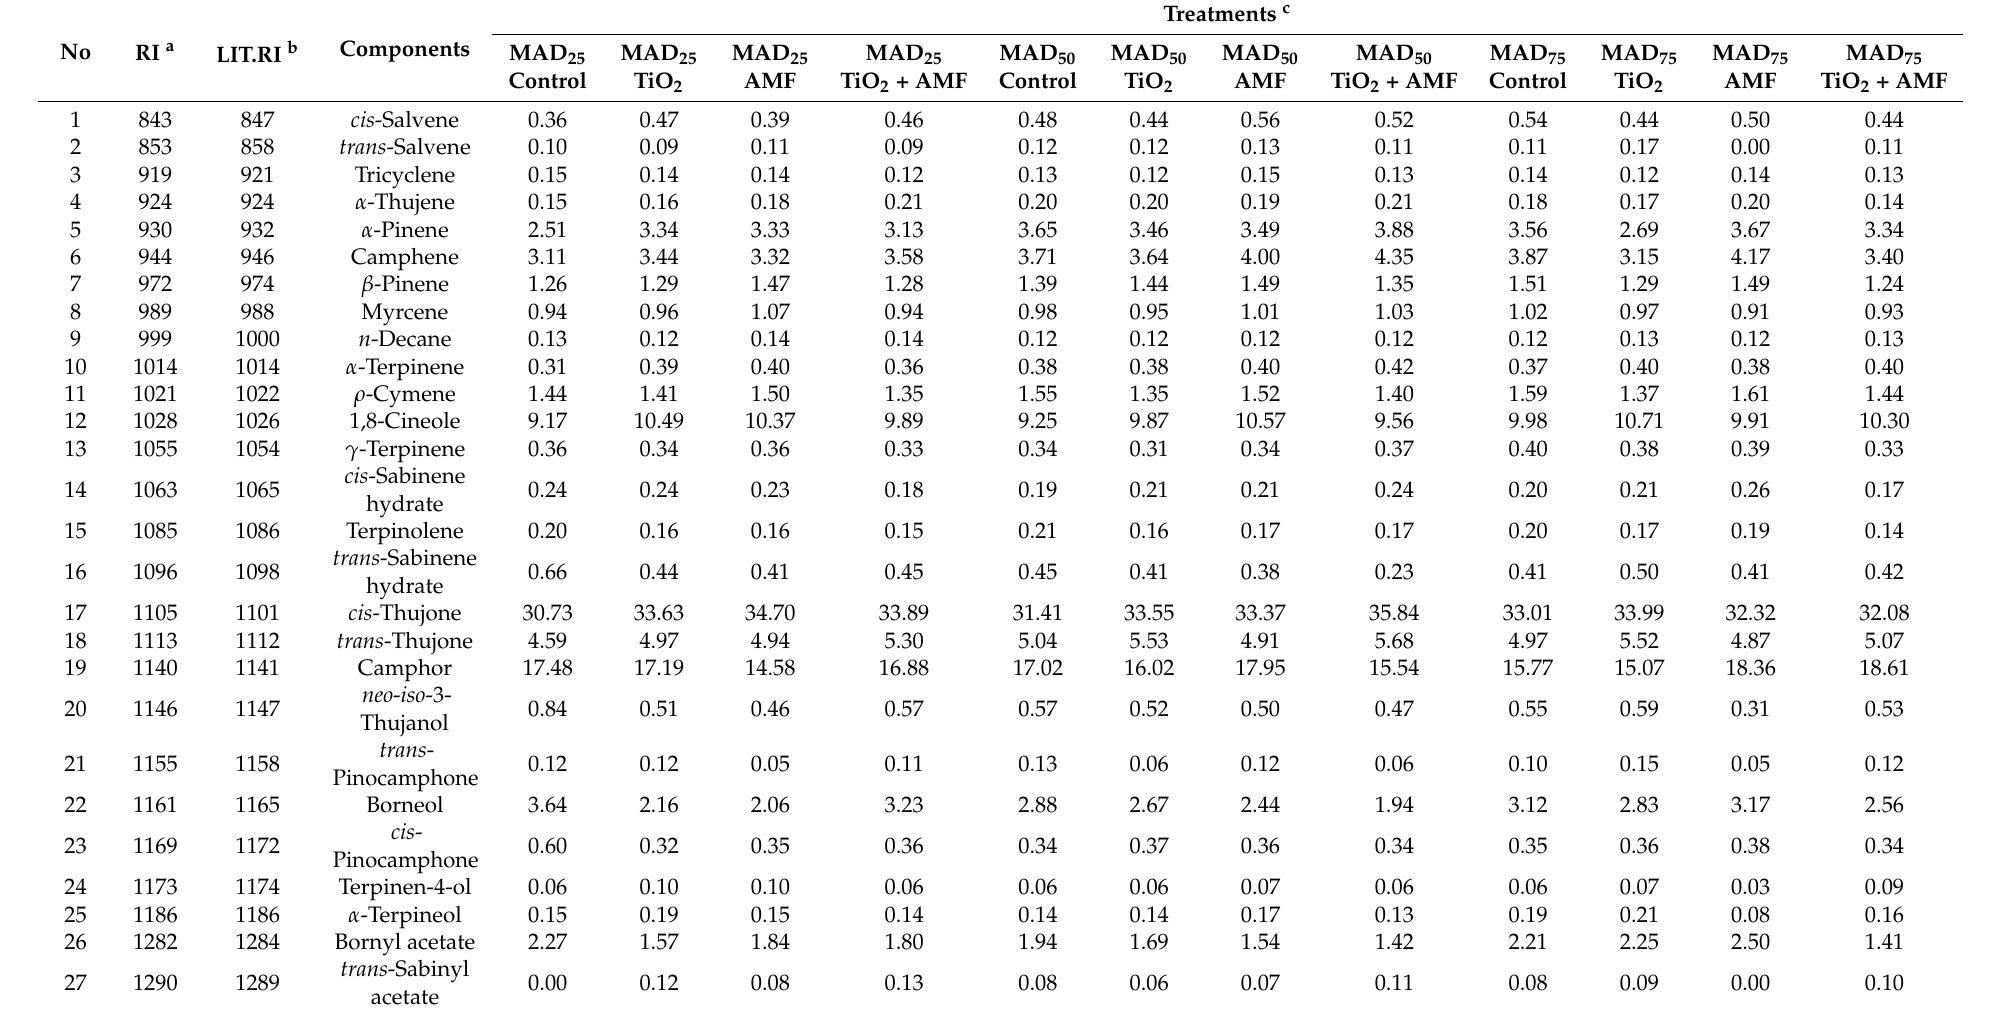
Table 3. The essential oil constituents of sage in different irrigation regimes and fertilizer sources (average of two